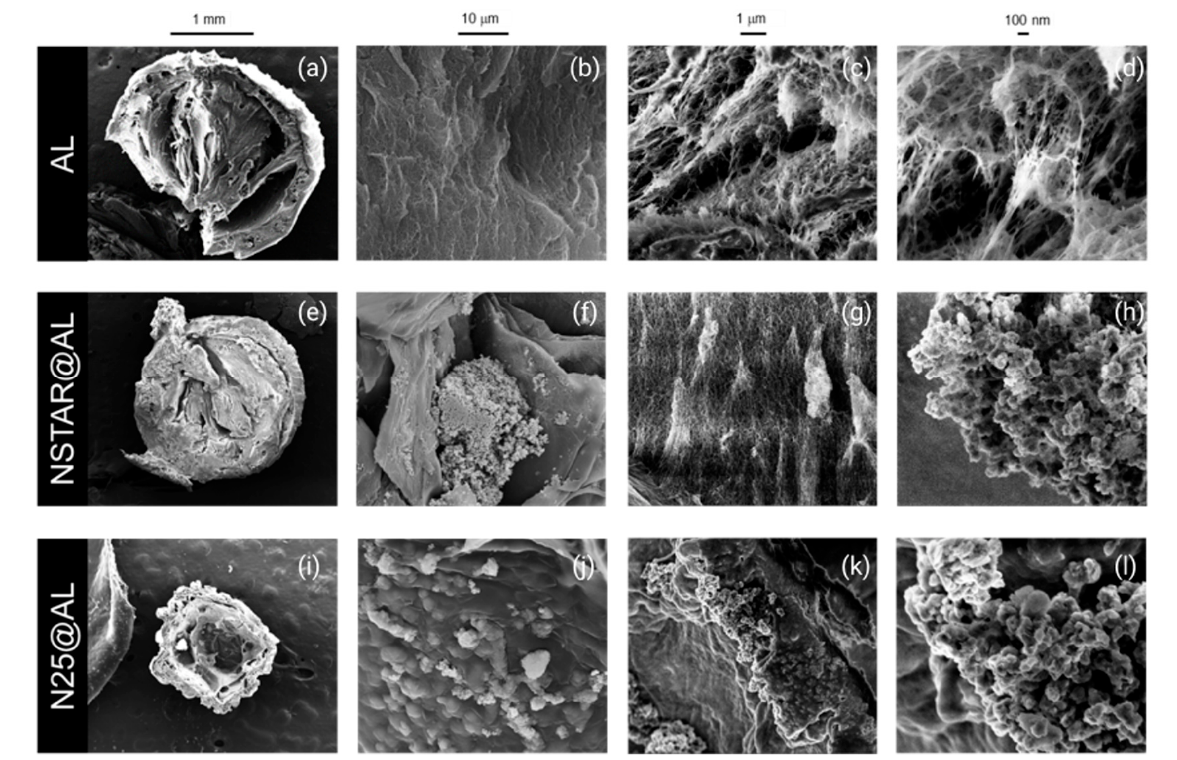
Figure 1. SEM images of AL beads, NSTAR@AL, and N25@AL beads in 100×, 6000×, 10,000×, and 100,000×, from left to right. The images of 100× and 6000× were taken with FEI Inspect F50 instrument, whereas the images with 10,000× and 100,000× were collected using a SUPRA 40 Carl Zeiss NTS microscope. In all cases, KL was used as source of AL.